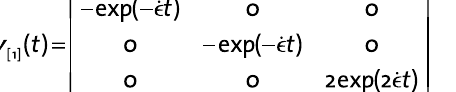
Figure 9: Critical gel-like behavior exhibited by a strong wheat flour dough: a) in small amplitude oscillatory shear flows (solid lines are the fits from Eq. 7, S = 5060 Pa·s n , n = 0.21); b) in transient uni- axial extension. The broken line represents predictions using a Lodge rubber-like liquid constitutive relation with the relaxation modu- lus determined from a). The solid blue line marks the lin- ear viscoelastic limit); c) Guided by the gel equation scaling of Eq. 14, we factor out the strain-rate depen- dence. The remaining strain-dependent function F ( e ) is plotted on semilog axes. Experiments conduct- ed at different strain rates now collapse onto a single curve. The dashed lines cor- respond to Eq. 14, while the dotted line corresponds to an exponential of the form exp ( ae ) with a =